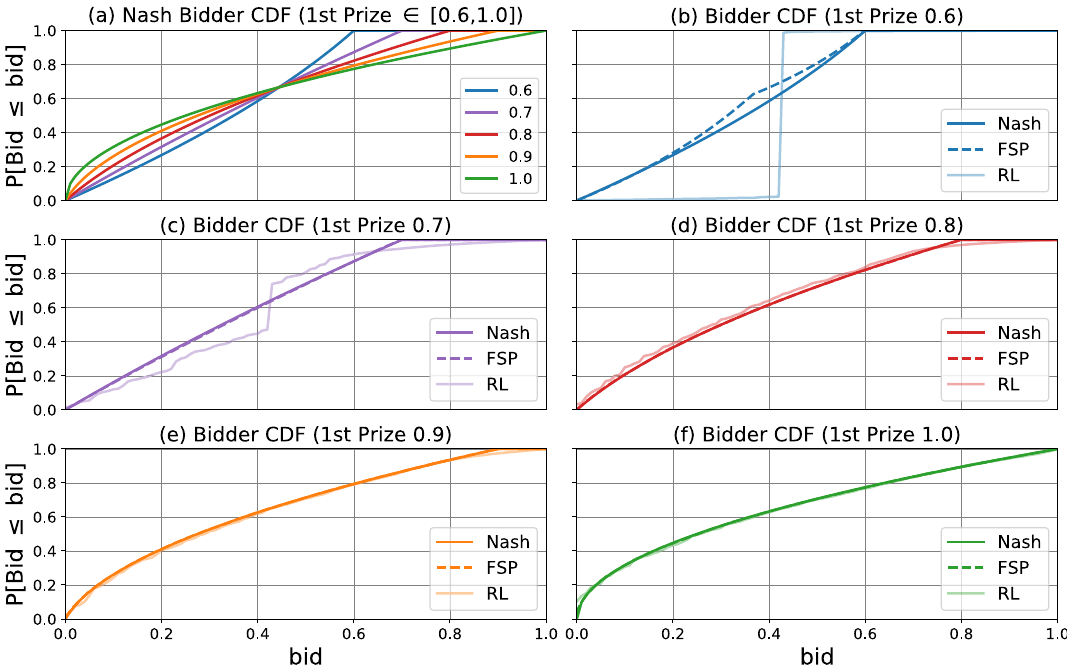
Figure 9. Bidder CDFs with reinforcement learning simulation. ( a ) shows the CDFs for each of five different auction designs assuming the bidder plays the Nash distribution. The first prize is listed in the legend; the second prize equals one minus the first; no prize is given to the third bidder. The remaining plots ( b – f ) compare the Nash CDF with the CDFs learned by Fictitious Self-Play and REINFORCE respectively using their optimal hyperparameter configurations (iterations, bid levels, learning rate, batch size). Both REINFORCE and Fictitious Self-Play agree closely with the Nash equilibrium when the first prize ≥ 0.8 . For smaller prizes, there is a larger discrepancy. FP is consistently closer to the equilibrium than Nash equilibrium for the game. It shows the same results as Fig. 3 but for varying number of FP rounds and discretization granularities for bid levels. Figure 8 indicates that the number of FP rounds and the granularity of discretization of bid levels have an impact on the learned bidding strategies. However, the results are somewhat robust to the choice of these param- eters, yielding similar bidding strategies under many settings. We examine independent multi-agent reinforcement learning (MARL) for the simulation phase. MARL methods have recently become popular for modeling agent behavior in multi-agent environments. The n -bidder All-Pay auction can be formulated as a multi-agent reinforcement learning problem as follows. The environ- ment contains only a single state s , where every episode begins. Each bidder i then simultaneously makes a bid b i . Finally, the environment calculates and distributes rewards to the agents according to the payoff function in Eq. (1). Formally, this is a one state Markov game 16 , i.e., a multi-agent bandit, with the relevant details given in Table 4. We use independent REINFORCE 36 , and investigate the bidding strategies learned by the agents. Bidding strategies learned using MARL are shown in Fig. 9, contrasted with the equilibrium and strategies learned via FP (similarly to Figs. 3 and 8). For large first prizes (0.8 or higher), all methods yield a similar distribution. However, there is a deviation for lower top prizes, where the RL distribution has a step function curve. Figure 9 indicates that the model for agent learning may impact the assumed bidding strategies (and hence on the choice of a design). Ultimately, we feel like this is a modelling decision on the user’s side: in order to choose a good design, one must first determine what is a reasonable model of the learning behavior of agents. For All-Pay auctions, using FP yields results that are more similar to those of traditional Nash equilibrium analysis. In contrast, if one believes agents are more likely to be reinforcement learners, an alternative bidding strategy is a likely outcome. One possible choice is a conservative approach, where one only considers designs